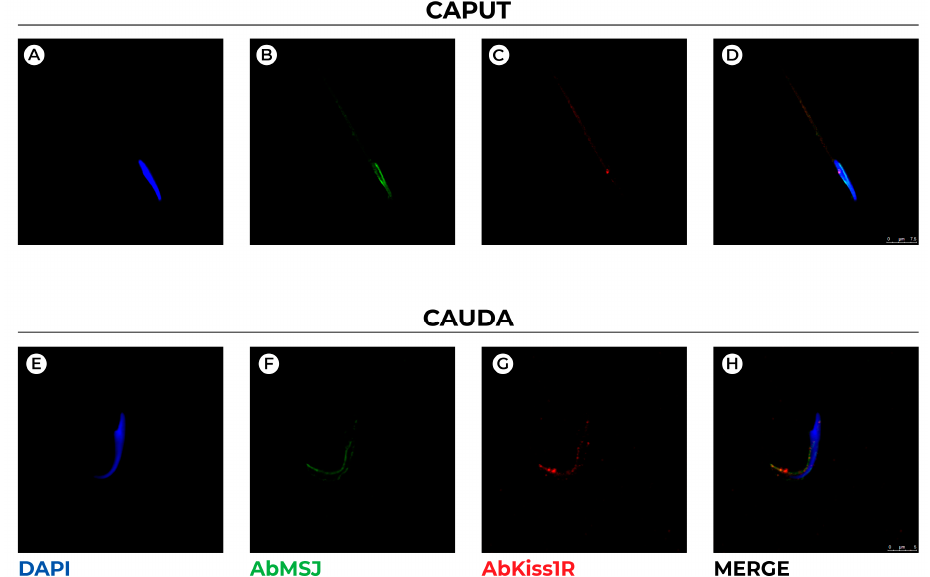
Figure 4. Confocal representative images showing double-immunofluorescence staining for MSJ-1 (AbMSJ, green) and Kiss1R (AbKiss1R, red) in rat spermatozoa collected from epididymis caput ( A – D ) and cauda ( E – H ). DAPI (blue) was used to counterstain sperm cell nuclei. Scale bar: 7.5 µ m ( A – D ); 5 µ m ( E – H ) .